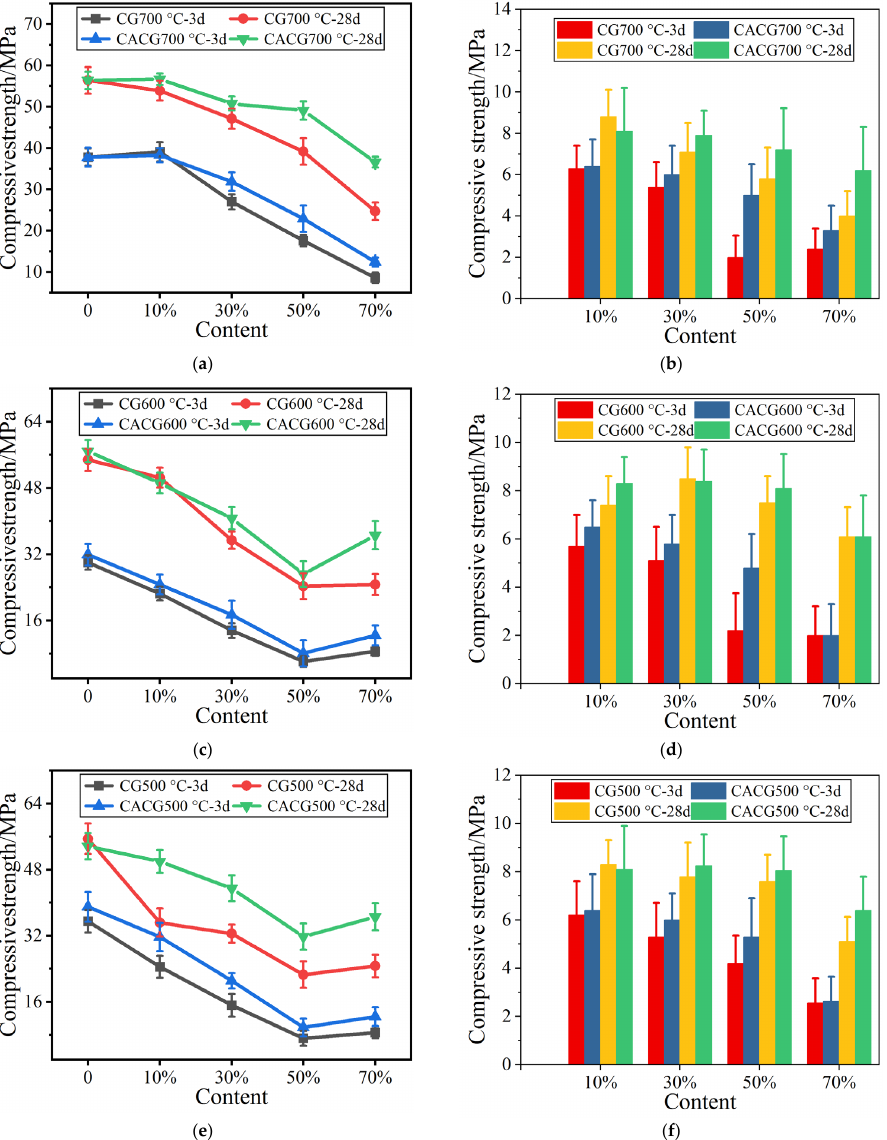
Figure 3. Strengths of mortars with calcined gangue and calcium - added gangue . ( a ) Compressive strength after 700 °C. ( b ) Flexural strength after 700 °C. ( c ) Compressive strength after 600 °C. ( d ) Flexural strength after 600 °C. ( e ) Compressive strength after 500 °C. ( f ) Flexural strength after 500 °C. strength after 700 ◦ C. ( b ) Flexural strength after 700 ◦ C. ( c ) Compressive strength after 600 ◦ C. ( d ) Flexural strength after 600 ◦ C. ( e ) Compressive strength after 500 ◦ C. ( f ) Flexural strength after 500 ◦